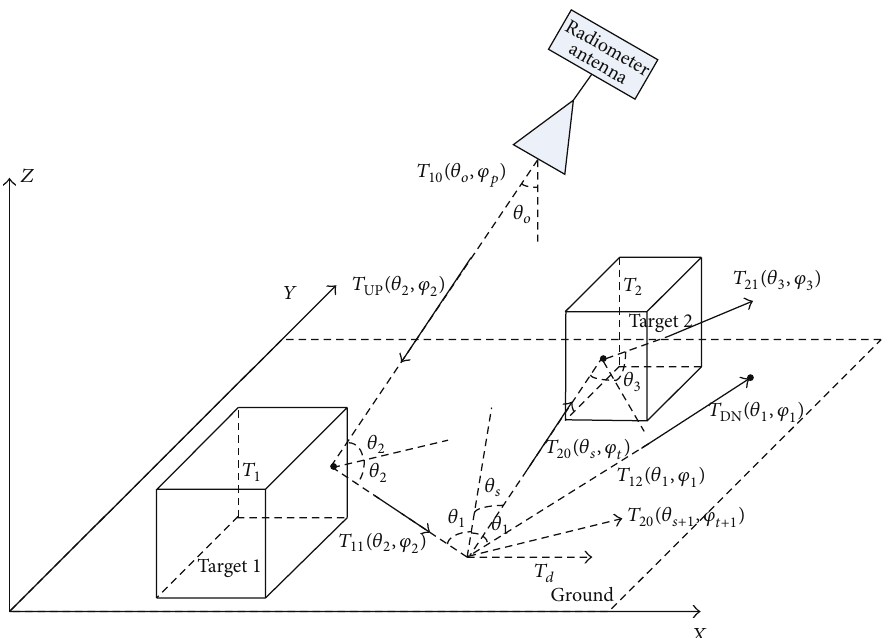
Figure 4: Model of MBTT